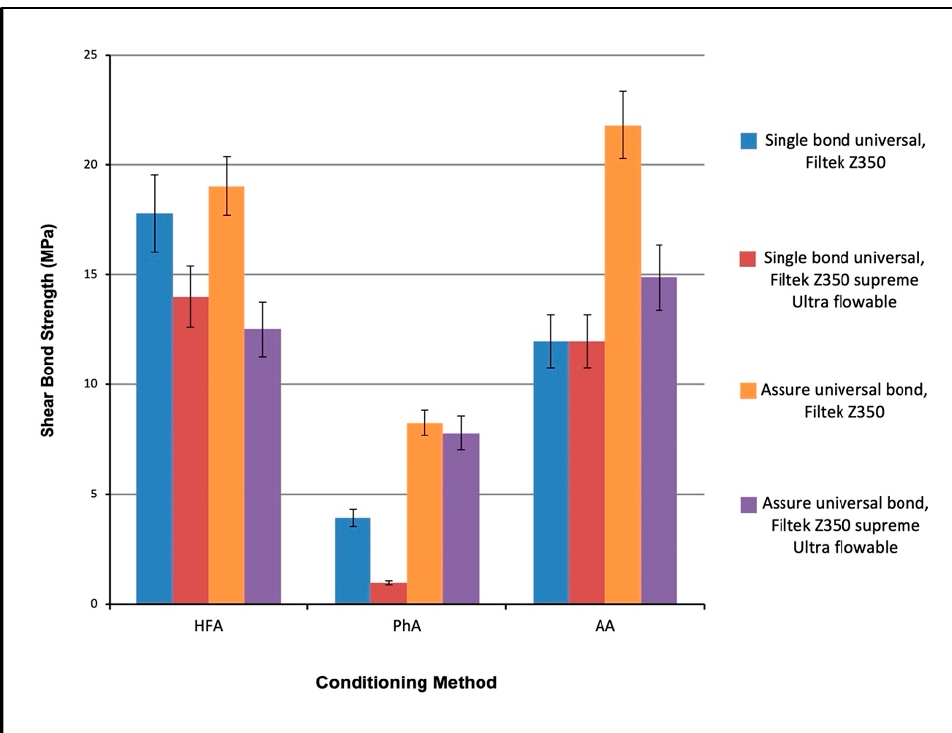
Figure 5. SBS for the interaction between different conditioning methods, bonding agents and composite types bonded to lithium disilicate glass ceramics. The interactions are presented grouped according to conditioning methods. Table 3. Post hoc Tukey test showing the interaction between the three factors: conditioning methods, bonding agents and composite types ( p <